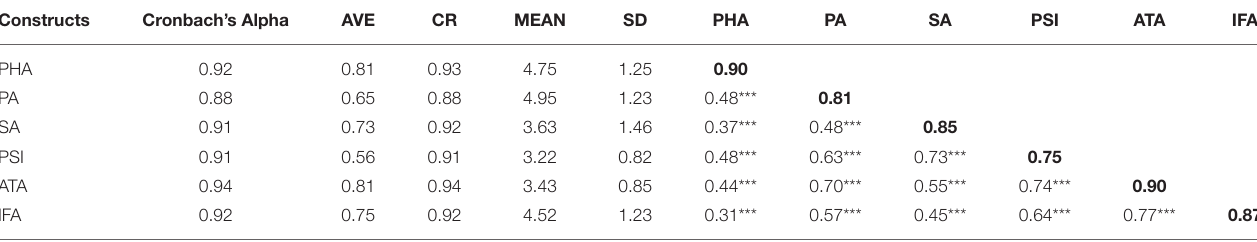
TABLE 2 | AVEs, CRs, and correlation coefficient between variables ( N = 355).